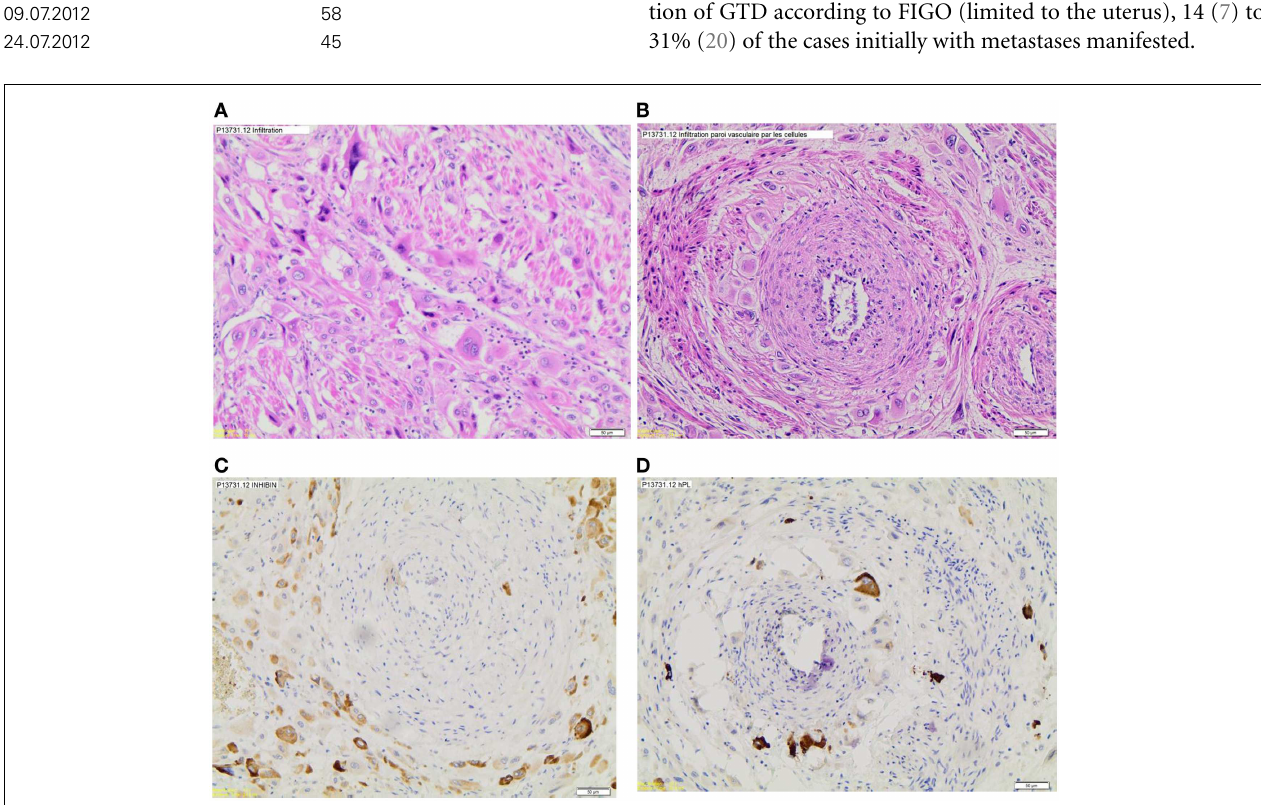
FIGURE 1 | Histologic sections . (A) Myometrium infiltration by tumor cells, (B) vascular invasion, (C) inhibin marking, and (D) HPL marking.